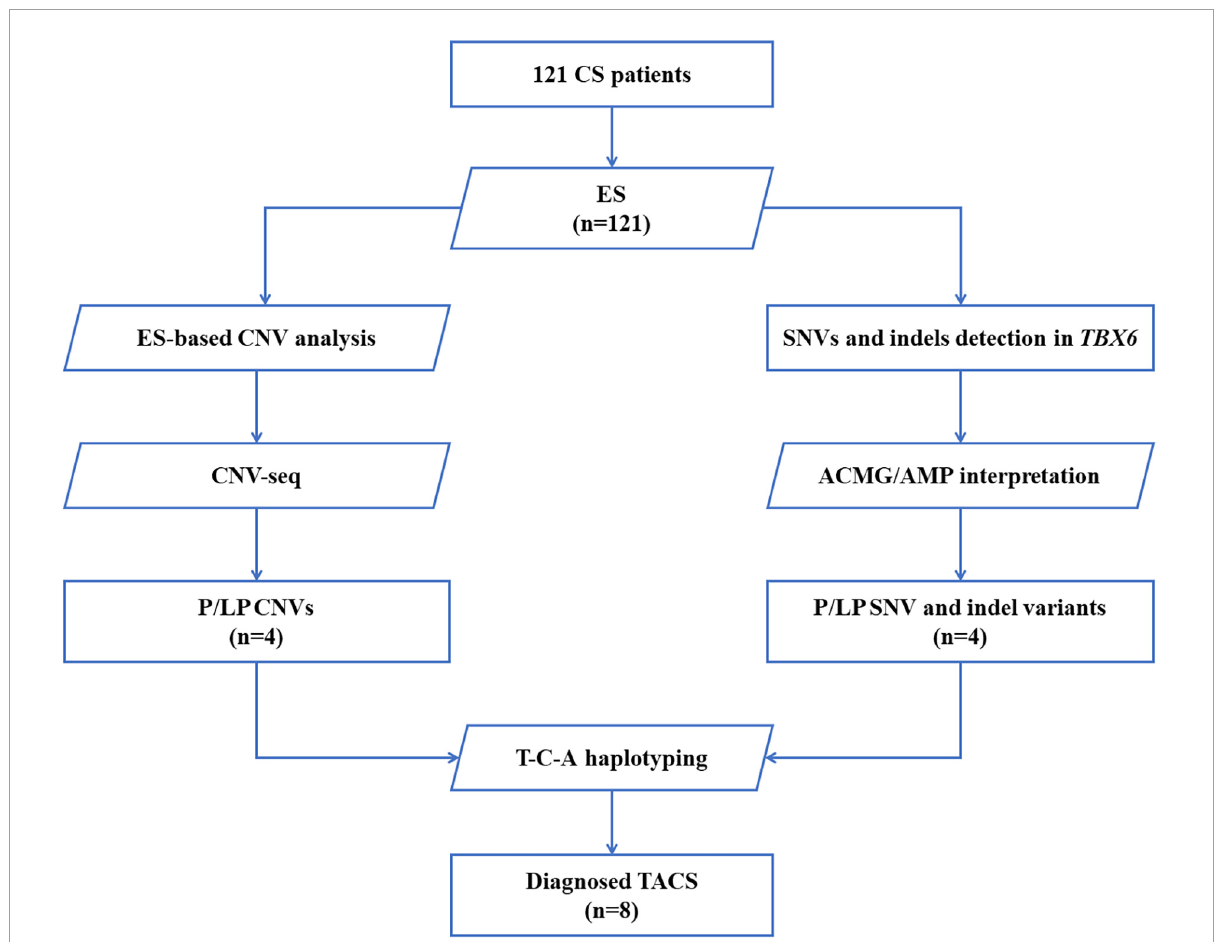
FIGURE1 Flow diagram of patients with CS who were enrolled and received genetic testing. A total of 121 patients were recruited, and exome sequencing was performed. SNVs and indels in TBX6 were evaluated by American College of Medical Genetics and Genomics (ACMG)/Association for Molecular Pathology (AMP) guidelines. CNVs were first analyzed based on ES data, further confirmed by CNV-seq, and classified by reported guidelines. The DNA of patients with pathogenic/likely pathogenic TBX6 variants (right branch) or TBX6 -involving CNVs (left branch) was amplified and sequenced to verify their T-C-A haplotypes. CS, congenital scoliosis; ES, exome sequencing; SNV, single nucleotide variation; indel, inversion and deletion; CNVs, copy number variations; ACMG/AMP interpretation, American College of Medical Genetics and Genomics and the Association for Molecular Pathology interpretation standards and guidelines; P, pathogenic; LP, likely pathogenic; T-C-A, rs2289292 (C > T) - rs3809624 (T > C) - rs3809627 (C > A); TACS, TBX6 -associated congenital